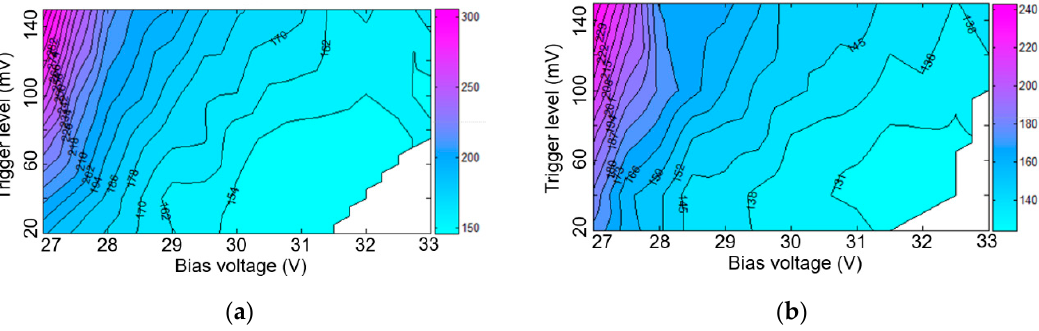
Figure 8. Contour plots of the FWHM CTR of 0.2% co-doped LYSO. ( a ) Polished crystal; ( b ) unpolished crystal.